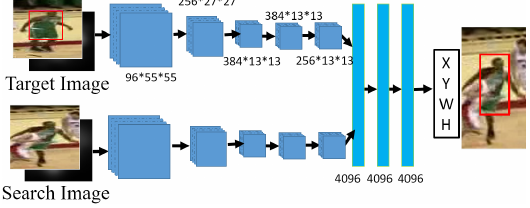
Figure 7. The architecture of localization